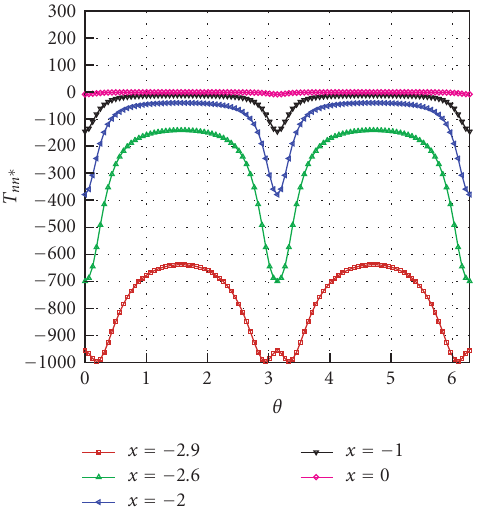
Figure 6.13. Dimensionless normal stress as a function of the polar angle θ for the di ff erent cross sections of the frontal part of the ellipsoid shown in Figures 6.2–6.6 ( x ≤ 0). The normal stress is compression in the fore part of the ellipsoid. The maximum compression is observed near the leading edge and decreases as we move towards the rear of the ellipsoid.